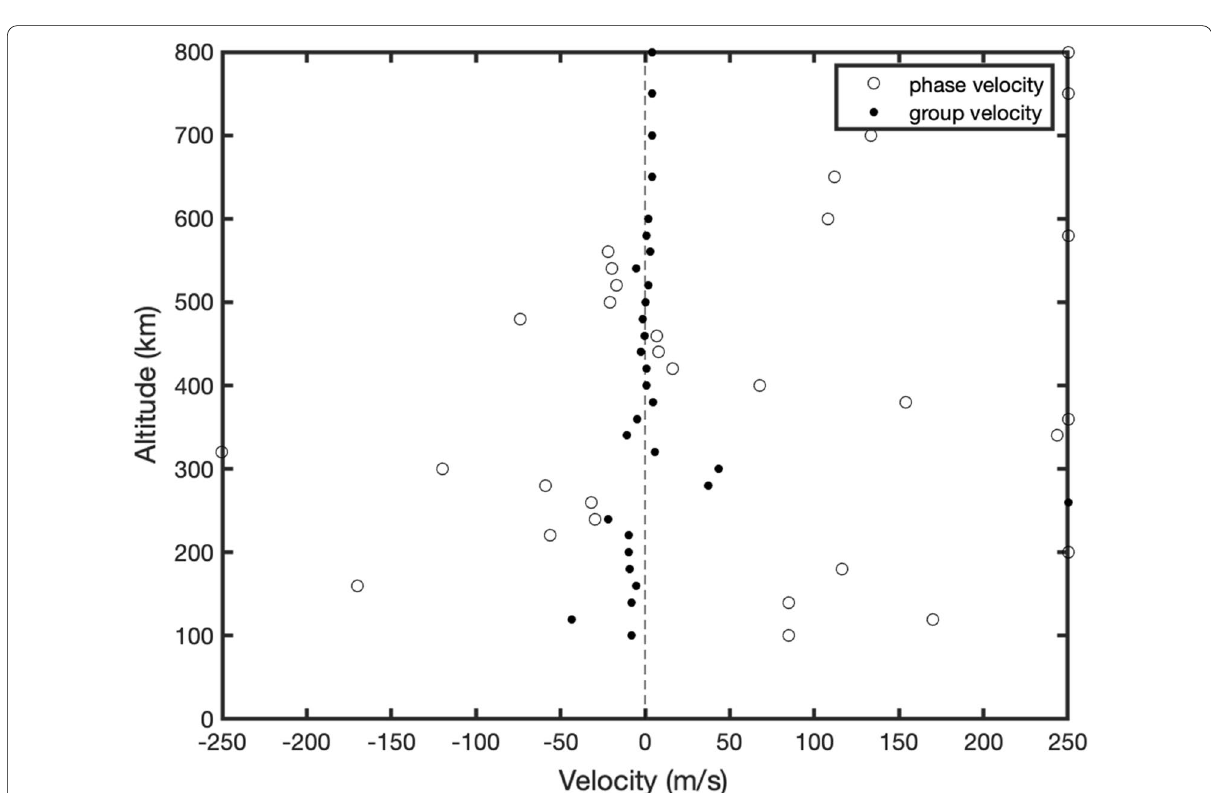
Fig. 8 The phase and group velocities of pronounced wave with center frequency (period) at various altitudes. The white and black cycles indicate the phase and group velocities,